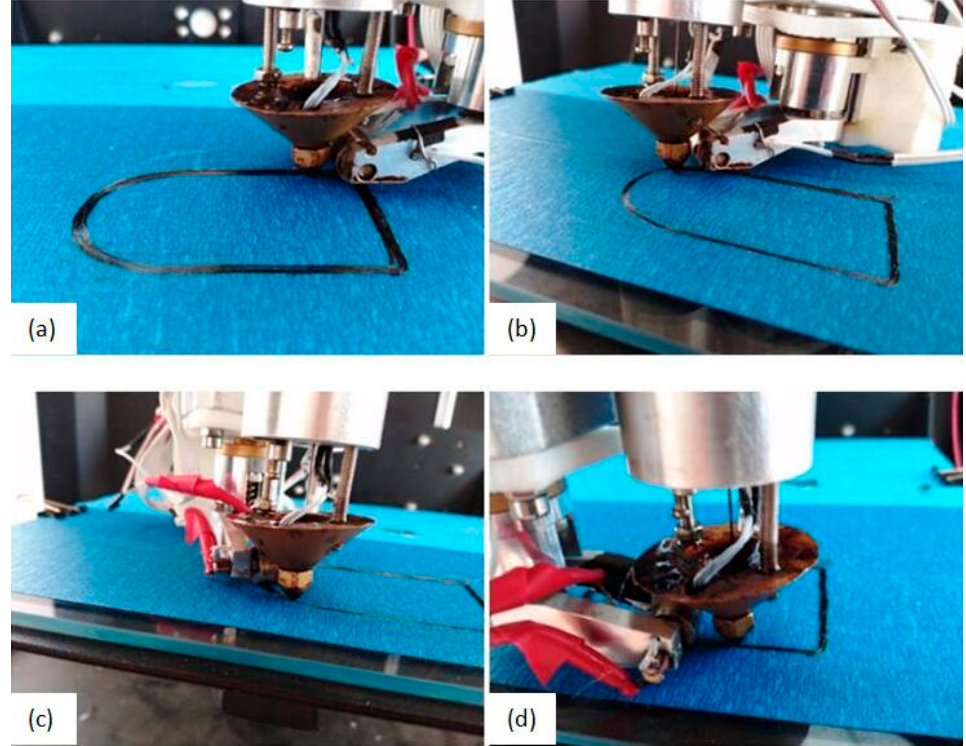
Figure 7. The four states of the pressure roller when printing a circle of paths. ( a ) state before rotation; ( b ) state after θ 1 rotation; ( c ) state after θ 3 rotation; ( d ) state after θ 4 rotation.